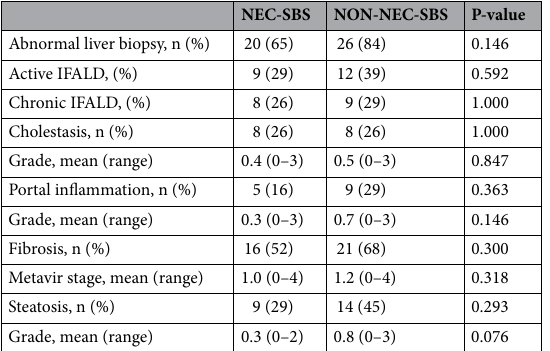
Table 3. Liver histopathological findings. Values are medians (interquartile range) or frequencies unless otherwise indicated. P-values are for Mann Whitney U test or Fisher’s exact test. IFALD intestinal failure associated liver disease, NEC necrotizing enterocolitis, SBS short bowel